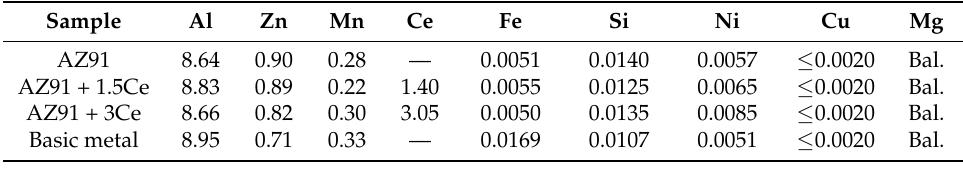
Table 1. Chemical compositions of welding wires and basic metal (wt %).